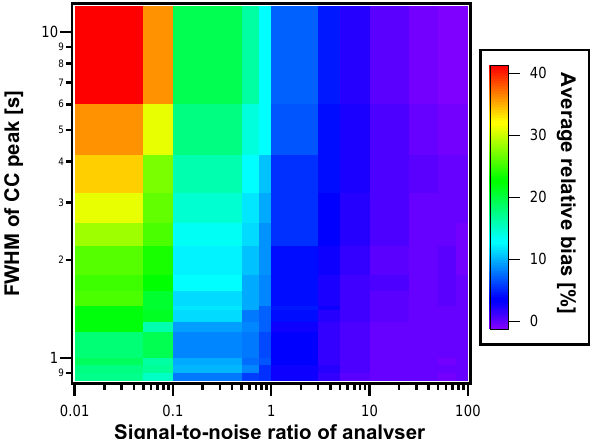
Figure 7. Image plot depicting the relationship between the average relative bias and both the signal-to-noise ratio of the analyser and the full width half maximum (FWHM) of the cross-covariance func- tion peak for simulated eddy-covariance flux data calculated using the MAX time-lag